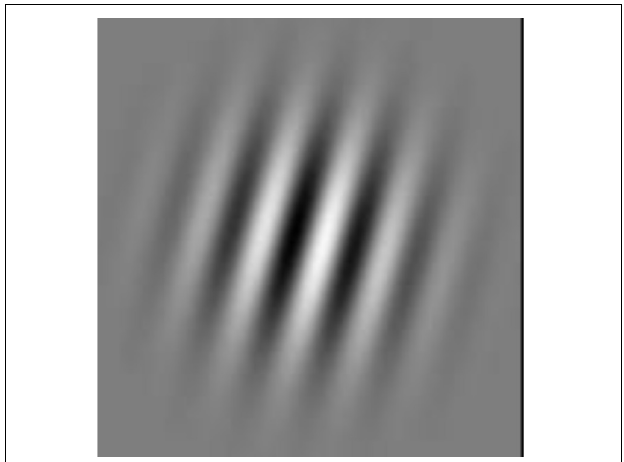
FIGURE 1 | Example of a Gabor stimulus used in Experiments 1 and